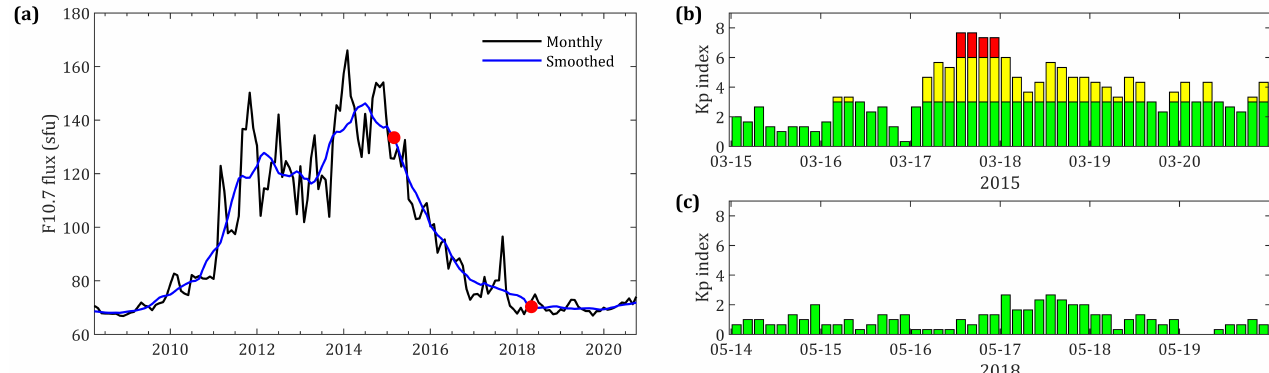
Figure 2. ( a ) Solar radio flux (F10.7) during the 24th solar cycle, which correlates to sunspot number. Red dots denote the periods considered in the data set. ( b,c ) Kp index with geomagnetic activity defined as low (green), medium (yellow) and high (red). The time series in 2015 shows medium and high Kp index values as a consequence of the St. Patrick’s Storm. During 14–19 May 2018, days were classified as quiet (low activity) according to Kp